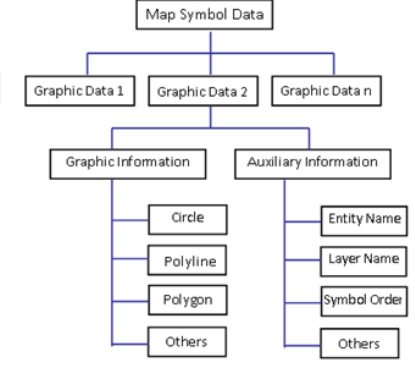
Figure 2. The structure of map symbol data.